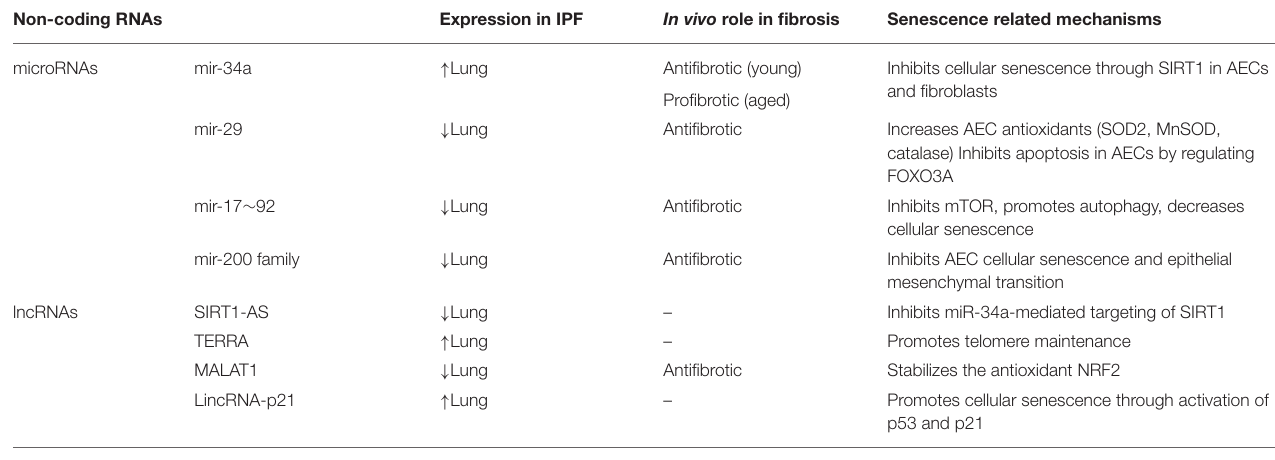
TABLE 1 | Aging related non-coding RNAs in IPF.